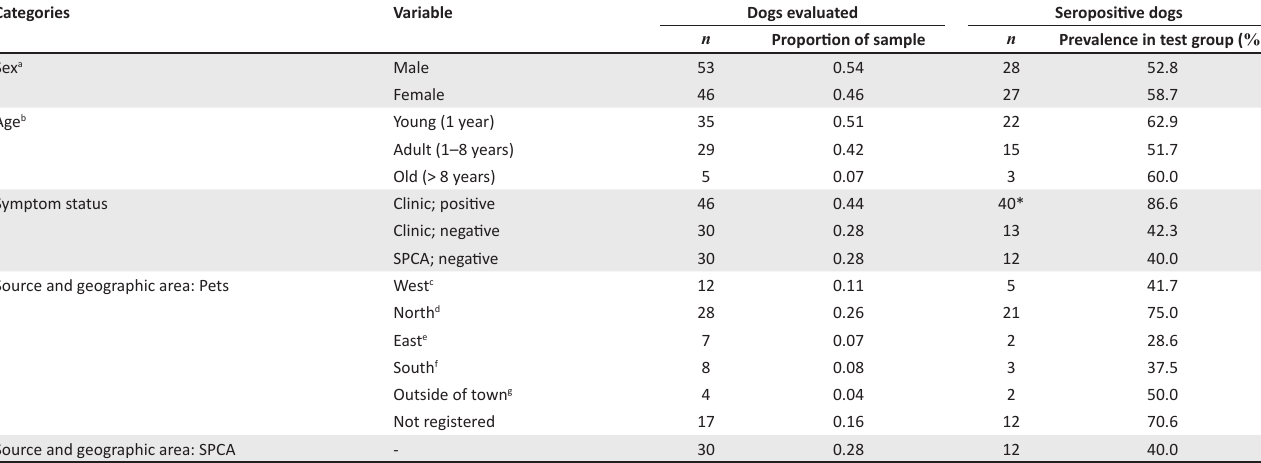
TABLE 1: Seroprevalence of Ehrlichia canis infection amongst a sample of dogs ( n = 106) in central Namibia.